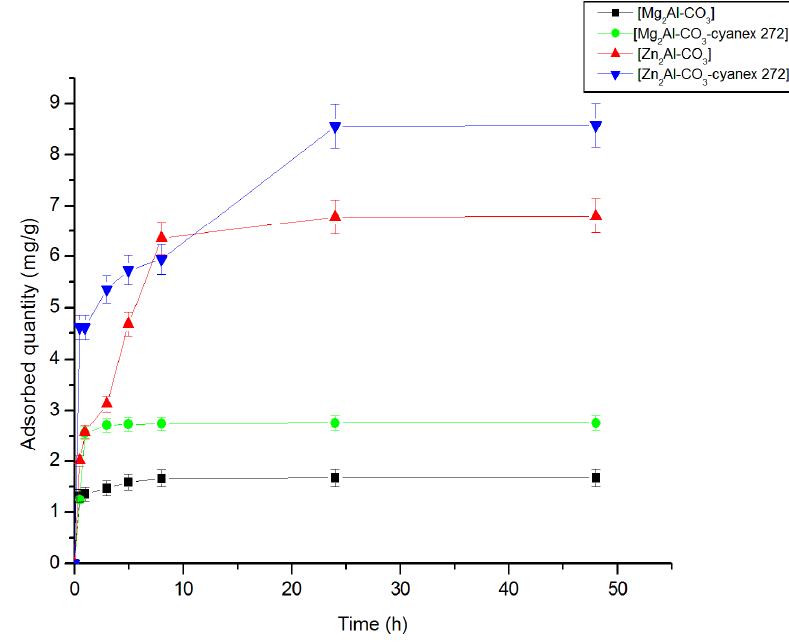
Figure 5. E ff ect of contact time on zinc removal (m = 0.1 g, pH 0 = 1.00 ± 0.05, [Zn + 2 ] = 100 mg.L − 1 , [Na + , H + -NO 3 − ] = 0.1 M, T = 25 ◦ Figure 5. Effect of contact time on zinc removal (m = 0.1 g, pH 0 = 1.00 ± 0.05, [Zn +2 ] = 100 mg.L − 1 , [Na + , H + -NO 3 − ] = 0.1 M, T = 25 °C).